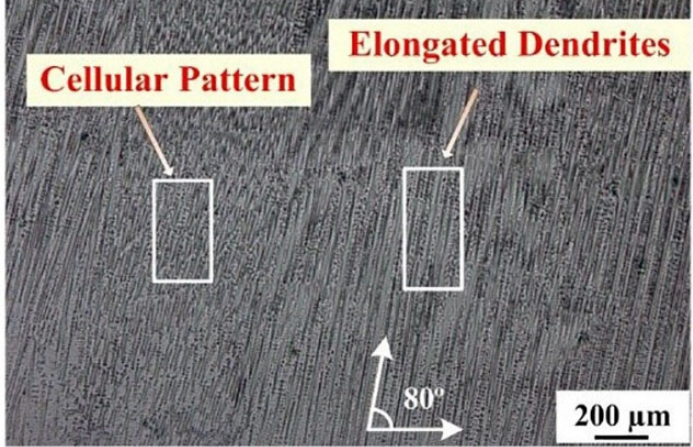
Figure 6. Structure of the C276 alloy product obtained by WAAM technology [69].